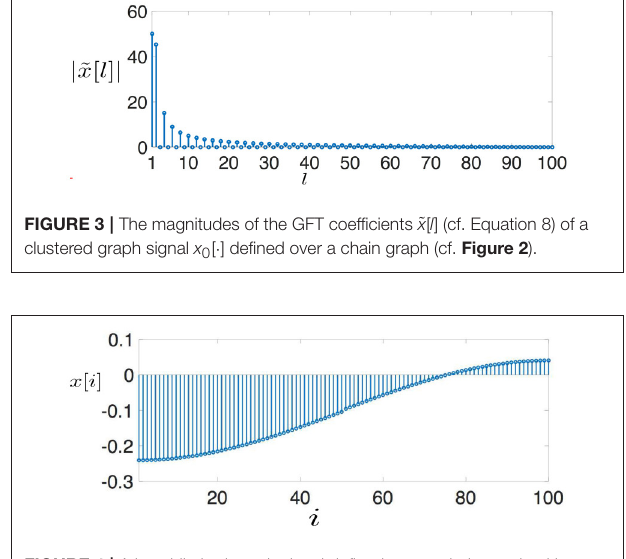
FIGURE 4 | A band-limited graph signal defined over a chain graph with N =